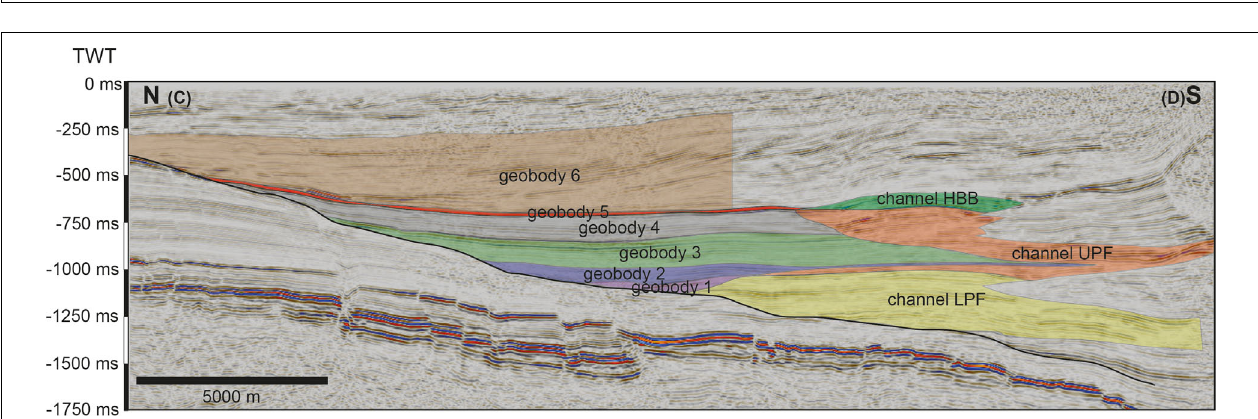
FIGURE 7 | Simplified lithological section of Well Z (for position see Figure 1 ) with FO and LO of index taxa [nannofossils and benthic foraminifera ( ´Cori´c and Spezzaferri, 2009)], TOC- and S-values are high in the UPF and CaCO 3 -content is highly variable (A1-horizon after Gross et al., 2018). At 1125 m TOC- and S-contents show a decrease, increase again and finally decrease to low and stable levels until the end of the section. See text for discussion.